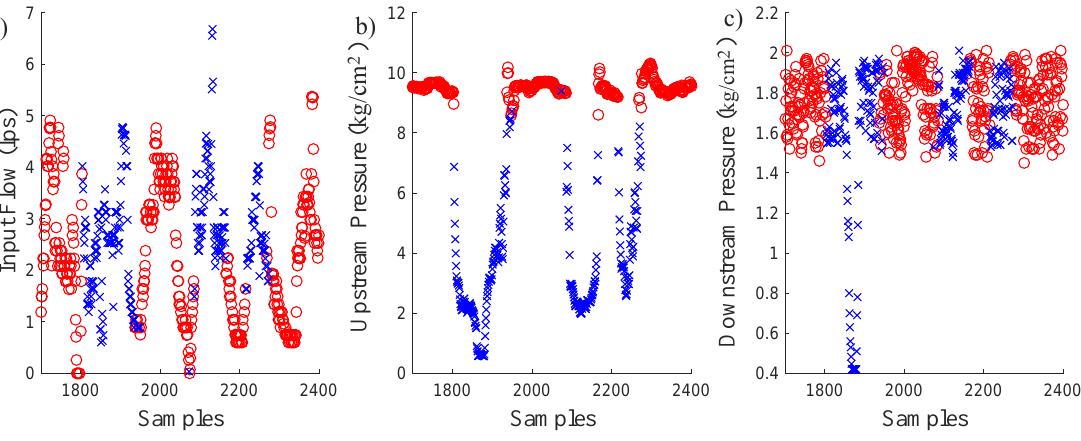
Figure 5. Classified raw data produced by reservoir